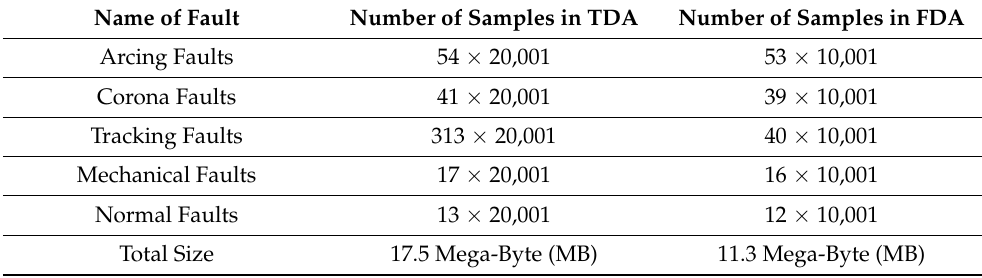
Table 1. The samples of datasets for arcing and non-arcing in the time and frequency